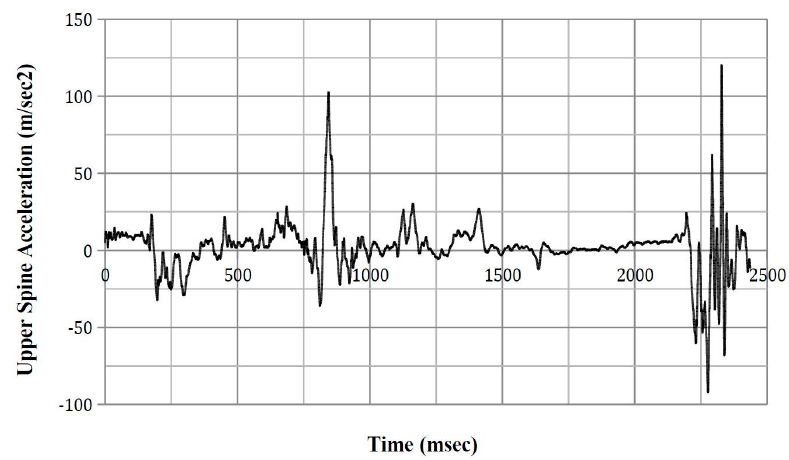
Figure A15. ATD Position 2 lower spine acceleration.